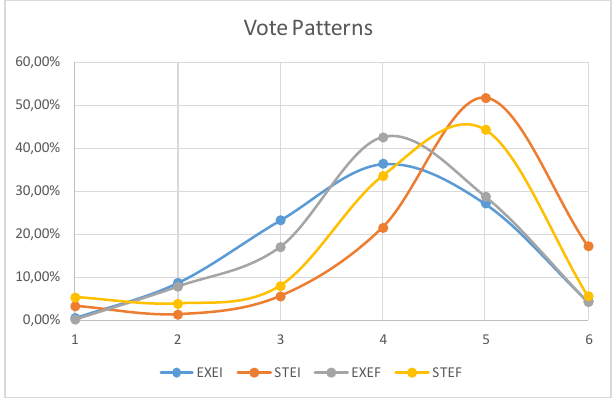
Figure 2 . Voting patterns between the participants Table 7. Participant correlation's